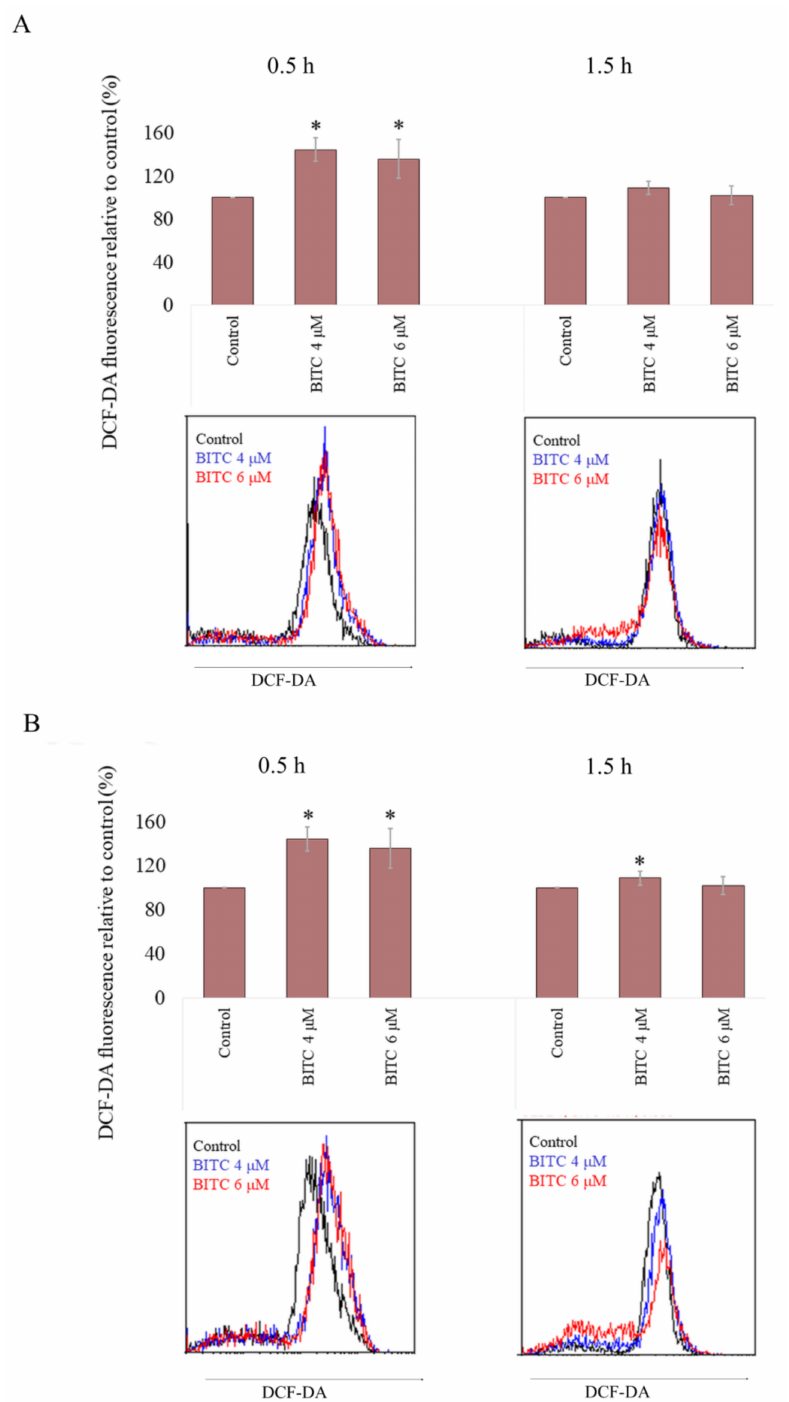
Figure 6. ROS increase after incubation with BITC. 2 (cid:48) ,7 (cid:48) -Dichlorofluorescin Diacetate (DCF-DA) fluorescence was measured after incubation of CLB70 ( A ) and CLBL-1 ( B ) cells with BITC for 0.5 h or 1.5 h. The values are means ± SD of three independent experiments. * Considered significant in comparison with control ( p <